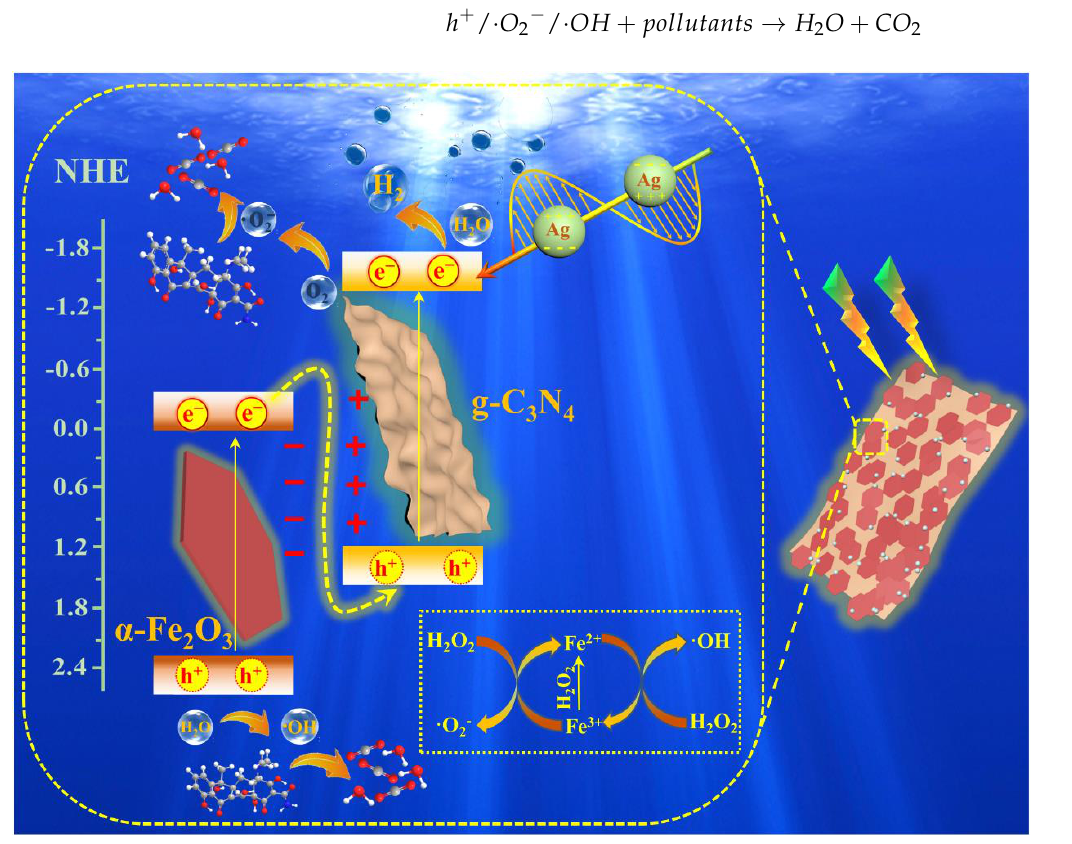
Figure 8. Schematic diagram of photocatalytic mechanism of Ag/α -Fe 2 O 3 /g-C 3 N 4 S-Scheme hetero- junction.